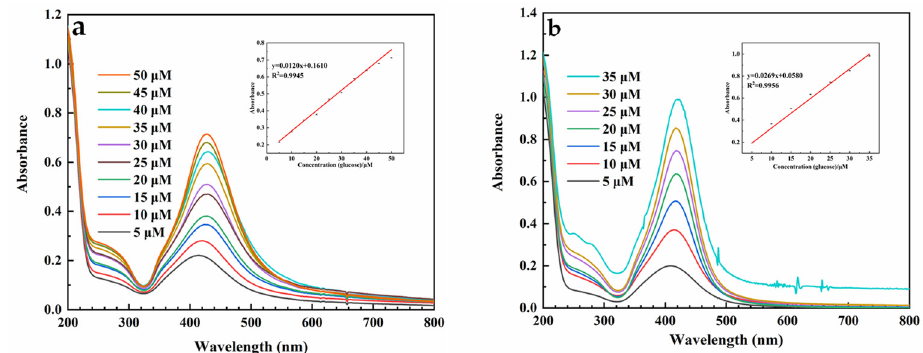
Figure 8. The UV-Vis spectra of the AgNPs mixed system (( a ), CNF-AgNPs; ( b ), CNC-AgNPs) ob- tained at different concentrations of glucose and the relationship between the maximum absorbance and the glucose concentration (the concentration of nanocellulose is 0.11 mg/mL, and the concentra- tion of silver ammonia solution is 0.6 mM).